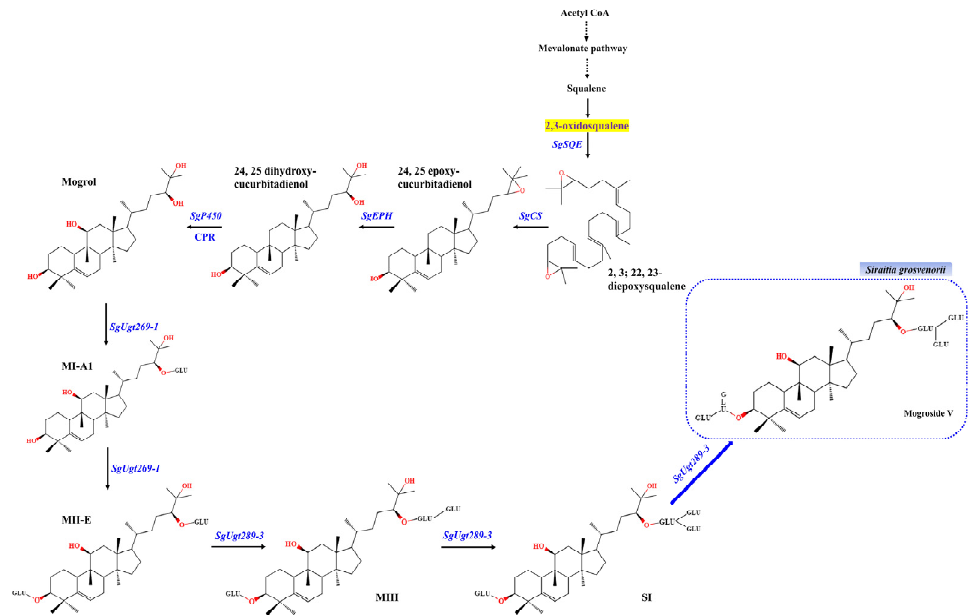
Figure 1. The Flow Chart of mogrosides biosynthetic pathway in Siraitia grosvenorii fruits. Mogrosides synthase genes which were transformed in this study are marked in blue, including SgSQE1 , squalene epoxidases; SgCS , curbitadienol synthase; SgEPH2 , epoxide hydrolases; SgP450 , cytochrome P450 mono-oxygenase; SgUGT269-1 and SgUGT289-3 , UDP-glucosyltransferases; The substrate, 2,3-oxidosqualene is shown with a yellow background. MI-A1, mogroside I-A1; MII-E, mogroside II-E; MIII, mogroside III; SI, siamenoside I; MV, mogroside V (in the dotted bordered